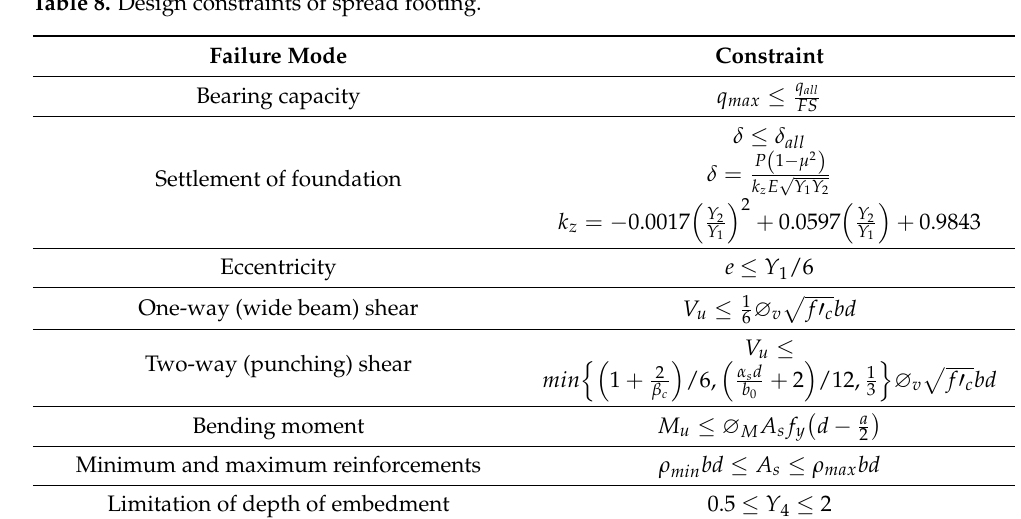
Figure 4. Design variables of the footing. Table 8. Design constraints of spread footing.